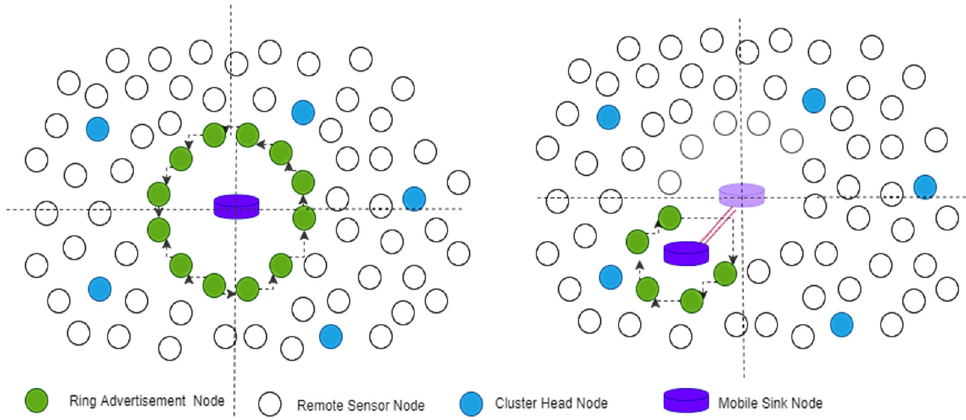
Figure 3. Mobile sensor network with the different categories of nodes .